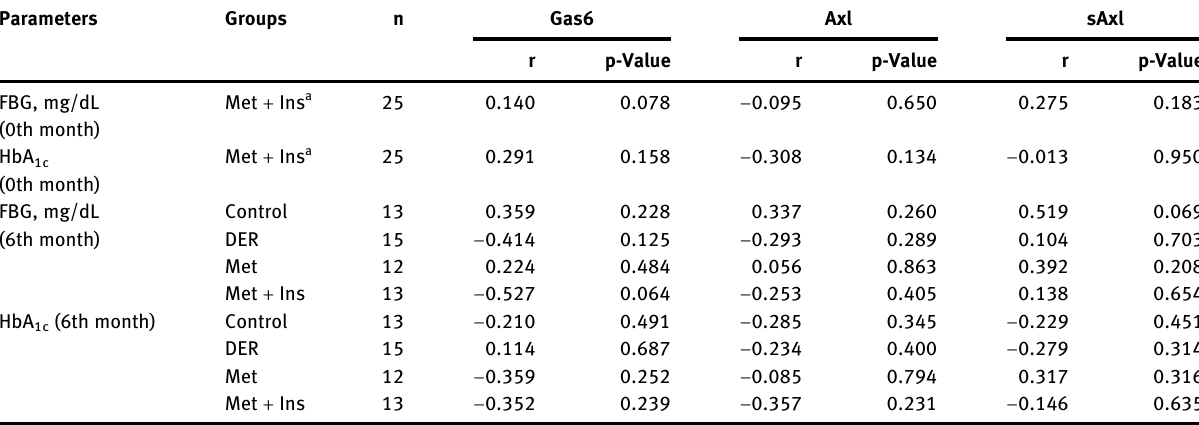
Table  : Correlation of FBG and HbA  c levels with Gas  , Axl, and sAxl parameters for baseline and  months.